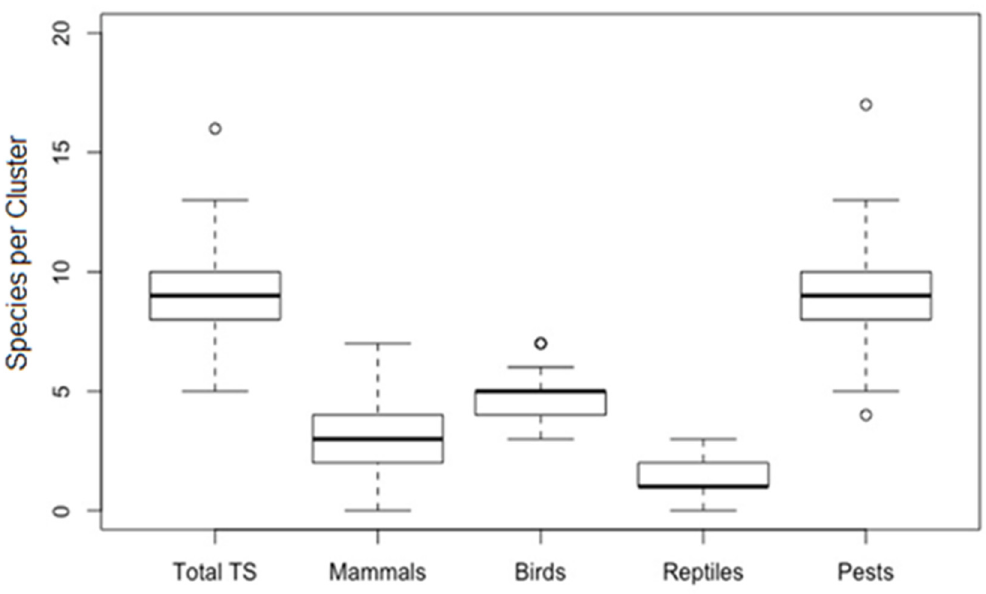
Animals 2019 , 9 , x FOR PEER REVIEW 9 of 16 Figure 4. Boxplot showing count of threatened species per cluster by phylum. Included is the total